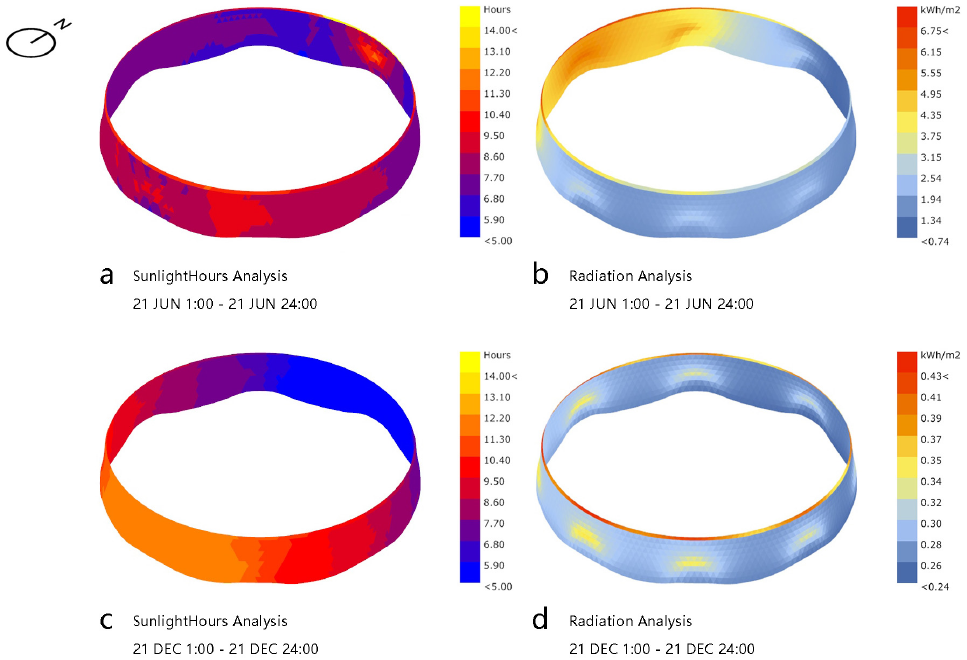
Figure 9. Simulation results of sunshine hours ( a ) and sunshine radiation ( b ) in the official Lady- bug Tools sample file.